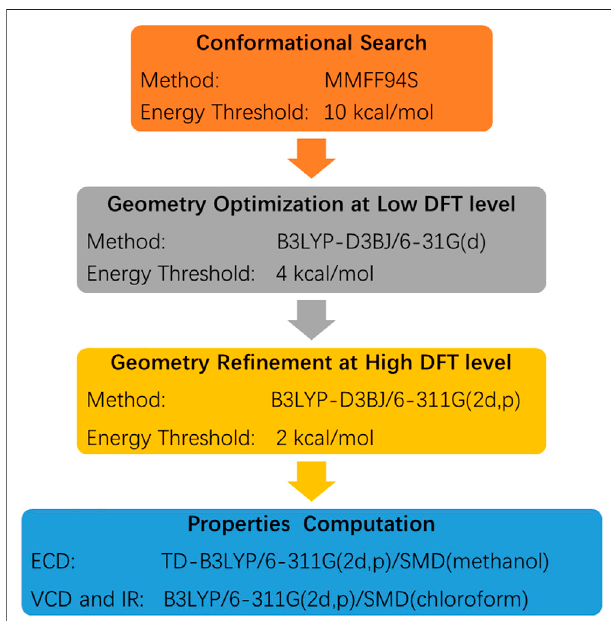
Scheme 1 | The procedure for the ECD and VCD computations.